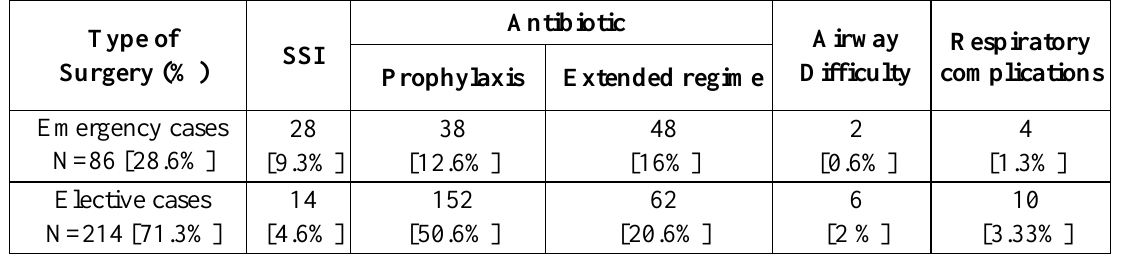
Table 6: Elective and emergency cases with respect to the outcome of the procedure and regime of antibiotic.